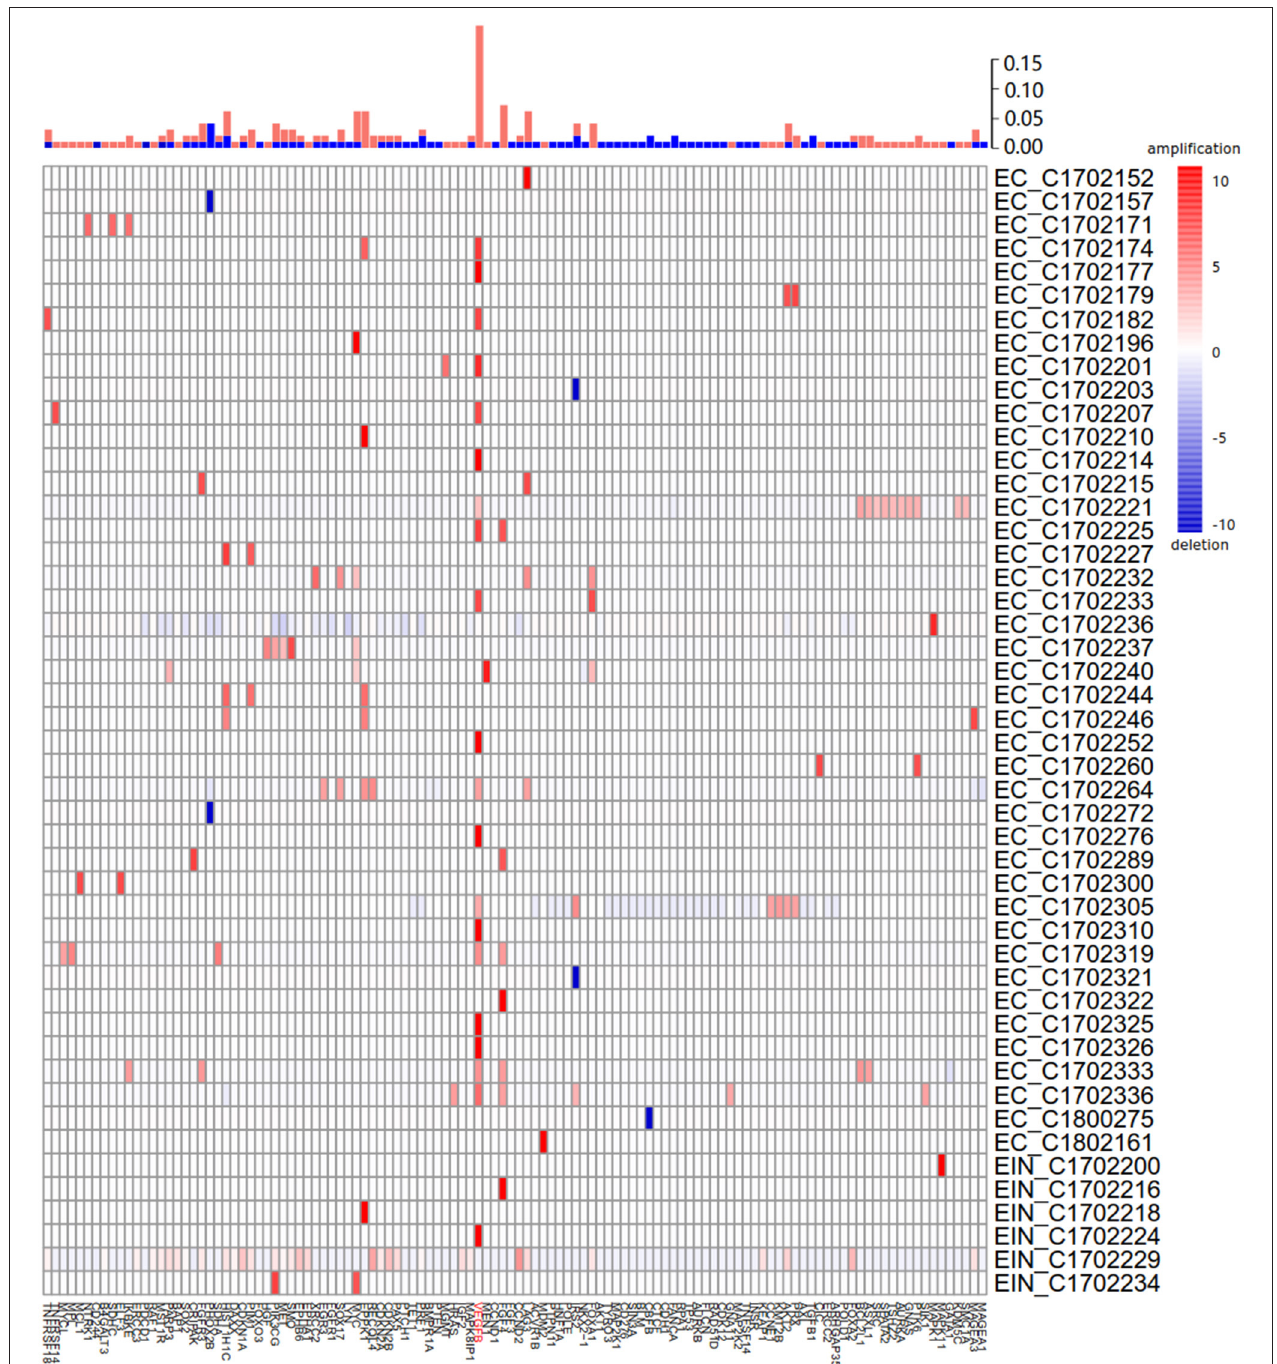
FIGURE 3 | Summary of all copy number aberrations in 48 samples. Upper bar, frequency of amplifications and deletions. Middle bar, heatmap of copy number aberration profiles of 48 samples. Amplified and deleted genomic regions are shown in red and blue, respectively. The high frequency of amplification of VEGFB is easily